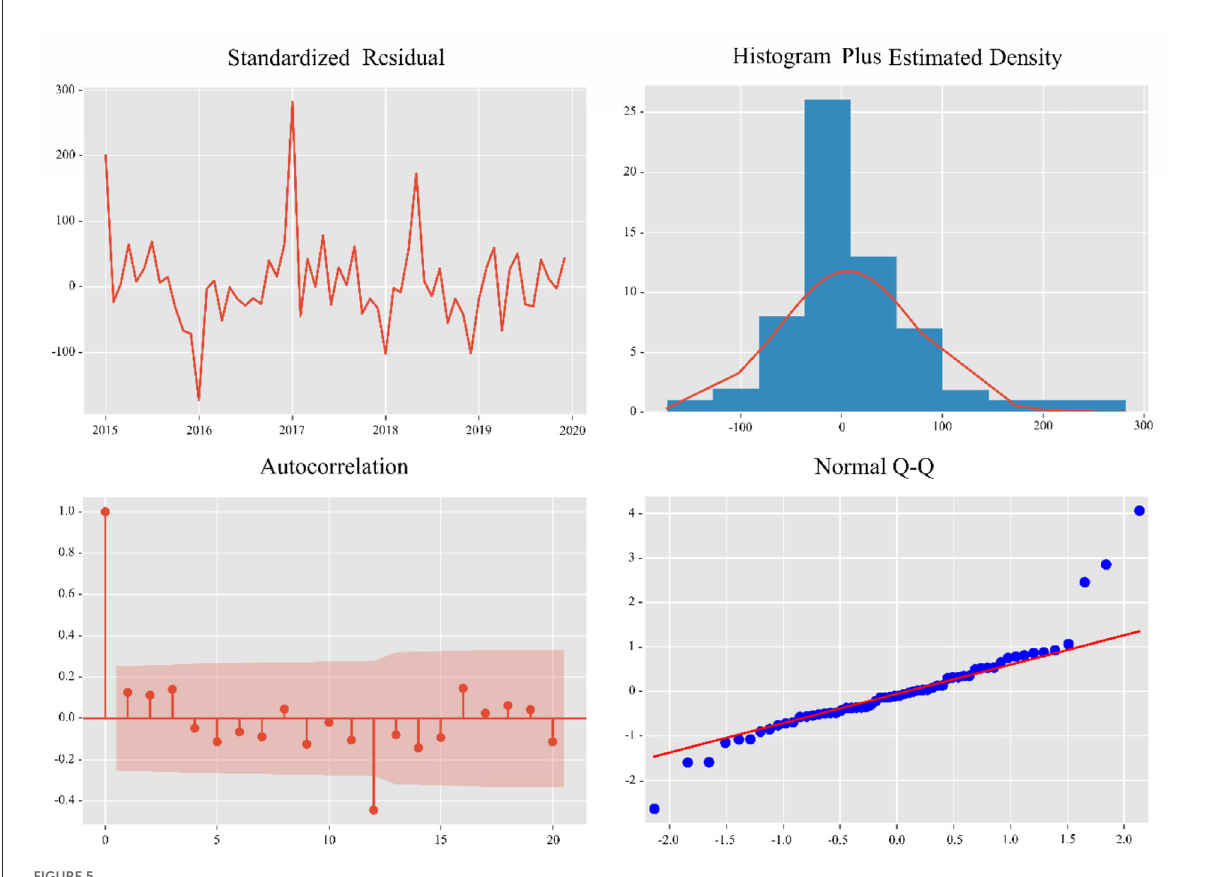
FIGURE5 Residual analysis of the SARIMA (1,1,0),(2,1,3) 12 model.